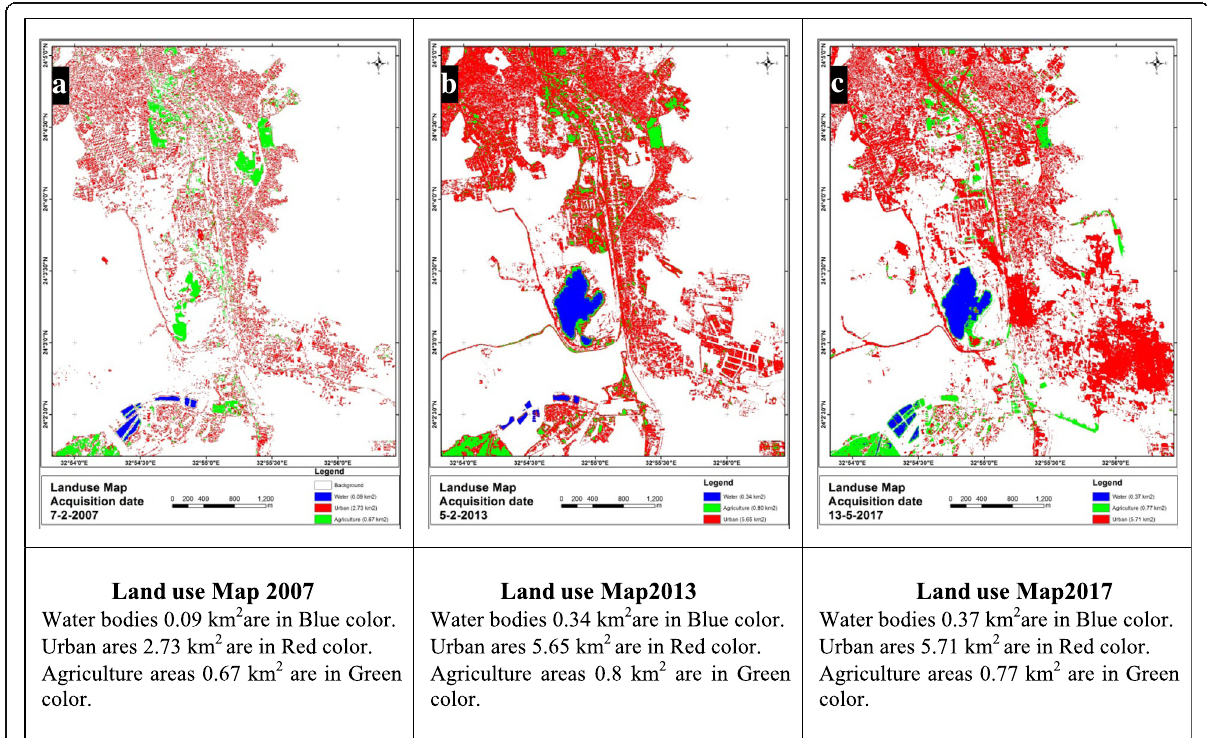
Fig. 9 General Landuse changes and detections during the period 2007-2017 a Landuse Map 2007, b Landuse Map2013 and c Landuse Map2017